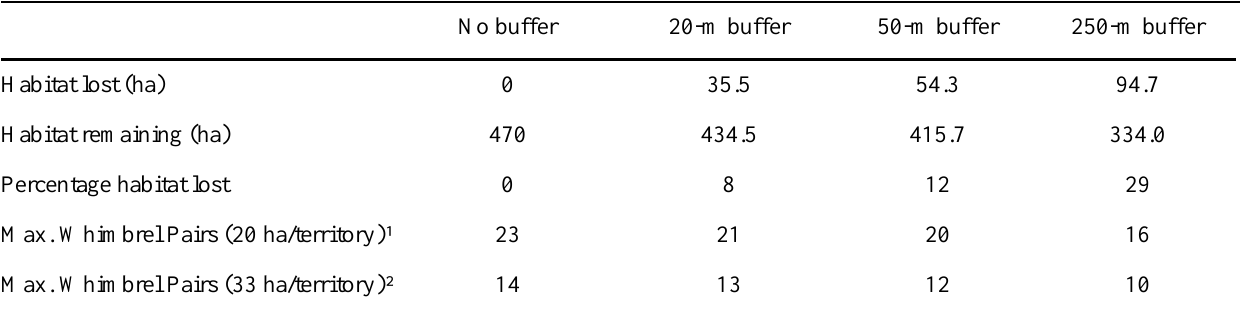
Table 5. Results for three scenarios potentially resulting from the construction of a natural gas-processing facility and pipeline in breeding Whimbrel habitat on Taglu and Fish Island in the outer Mackenzie Delta, Northwest